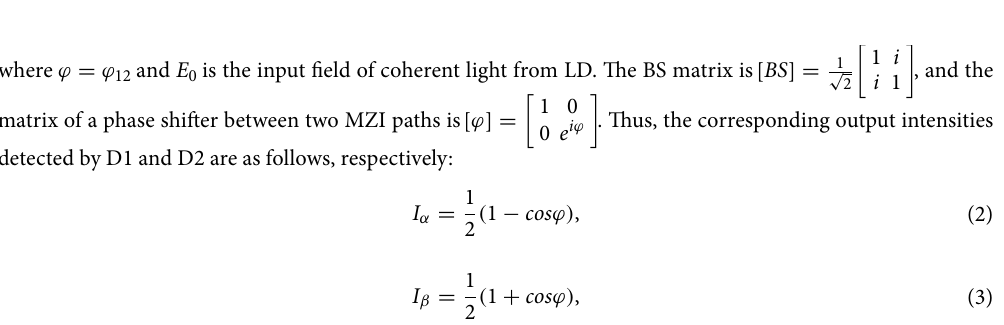
Figure 2. Numerical calculation for Eq. (4). ϕ (inversion) relation between two phase